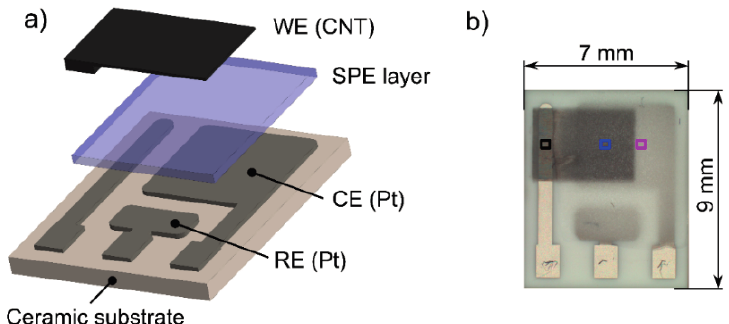
Figure 1. ( a ) Sensor layout; ( b ) Photograph of the nitrogen dioxide sensor (colored squares represent the areas captured in the SEM pictures (see Figure 5), black square (see Figure